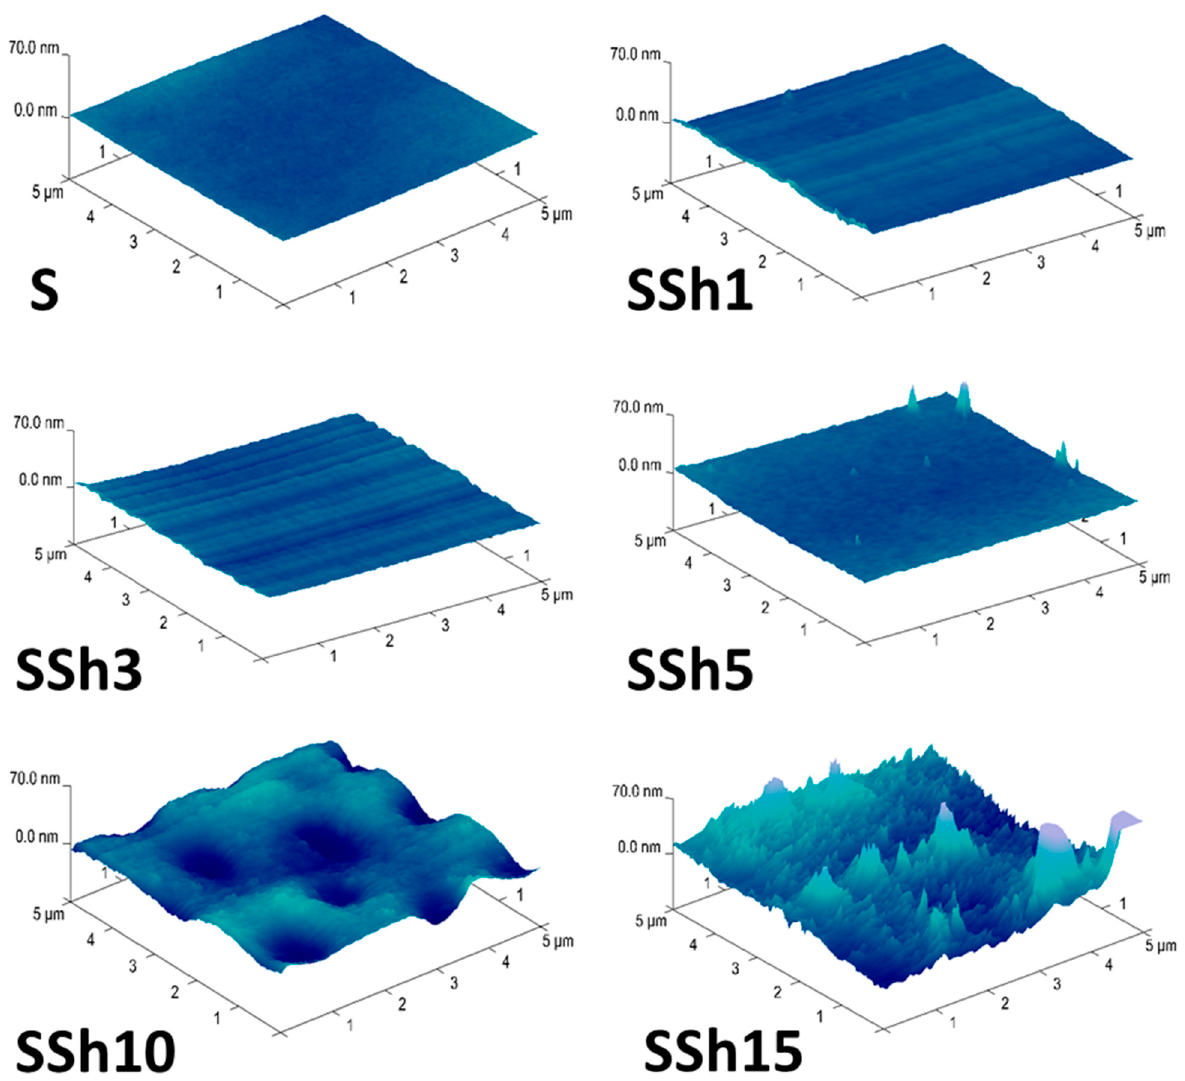
Figure 8. Atomic Force Microscope (AFM) images of pure Sylgard and its composites containing graphite.